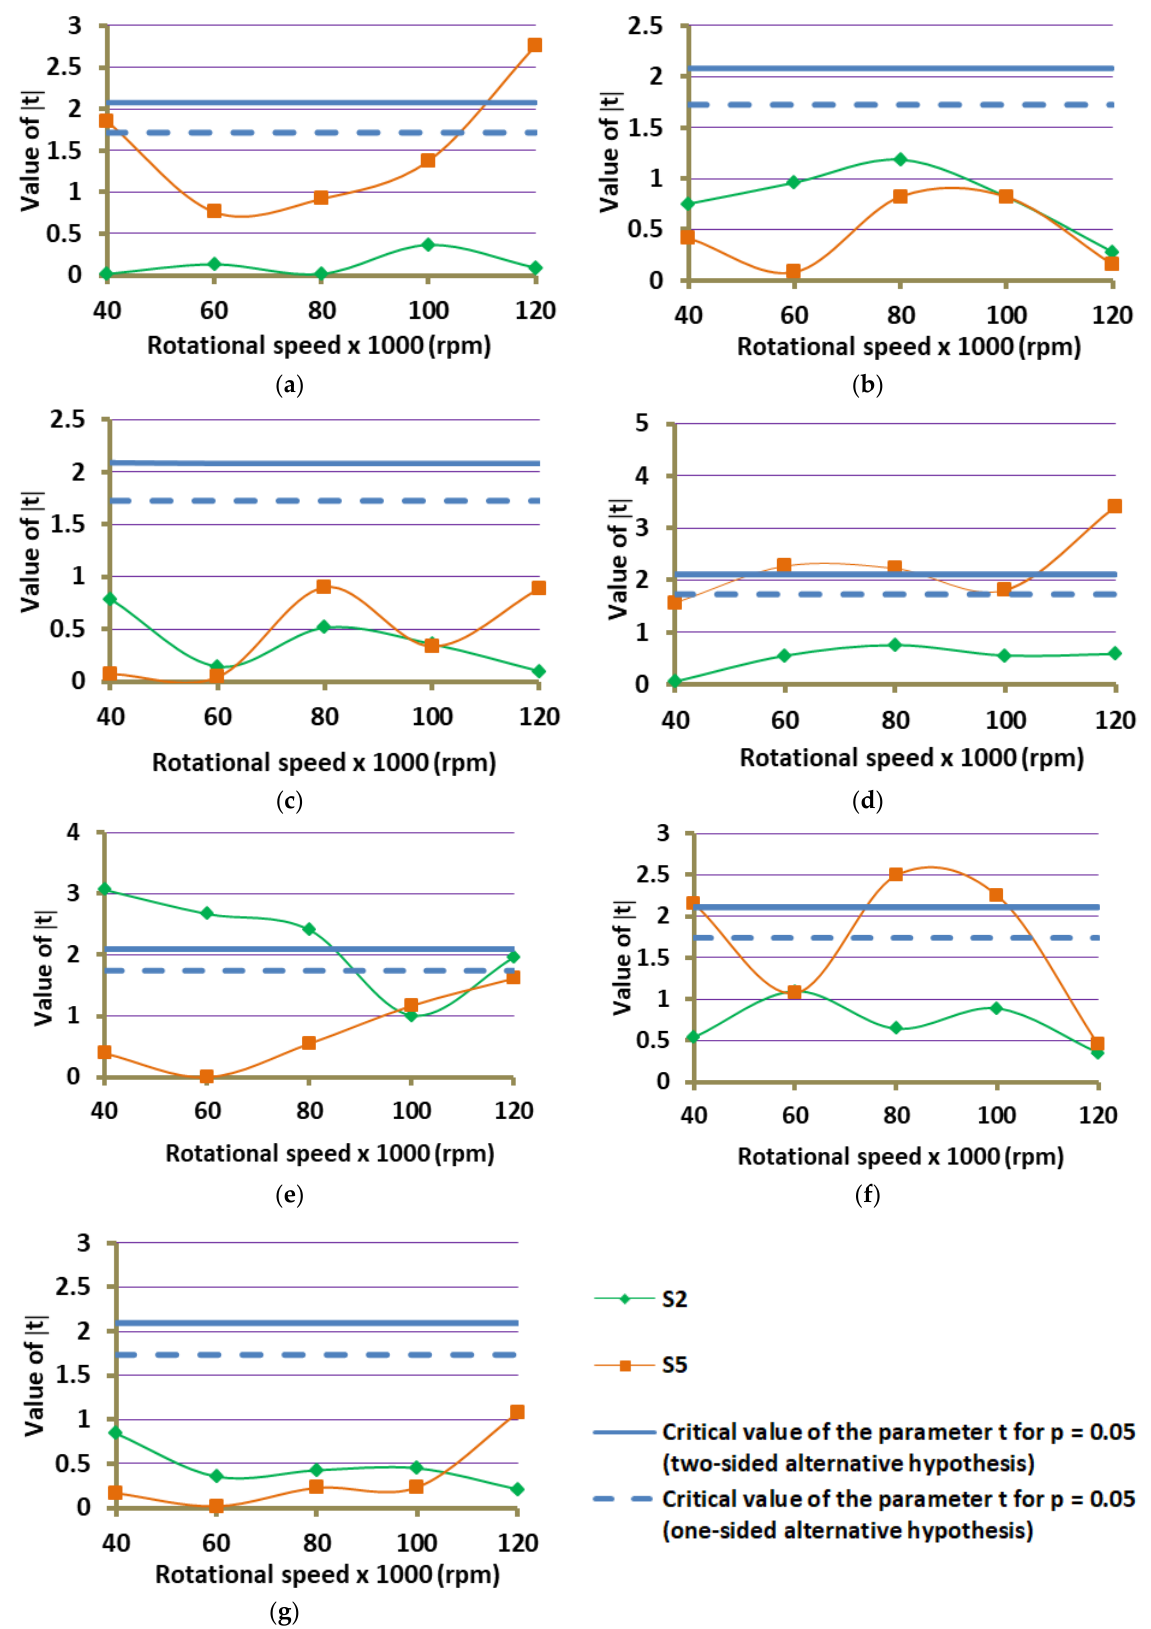
Figure 12. The value of the parameter t as a function of the rotational speed of the gas turbine for; ( a ) temperatures downstream of the combustion chamber, ( b ) thrust, ( c ) thrust-specific fuel consumptions, ( d ) NOx, ( e ) CO, ( f ) CO2, ( g ) O2.